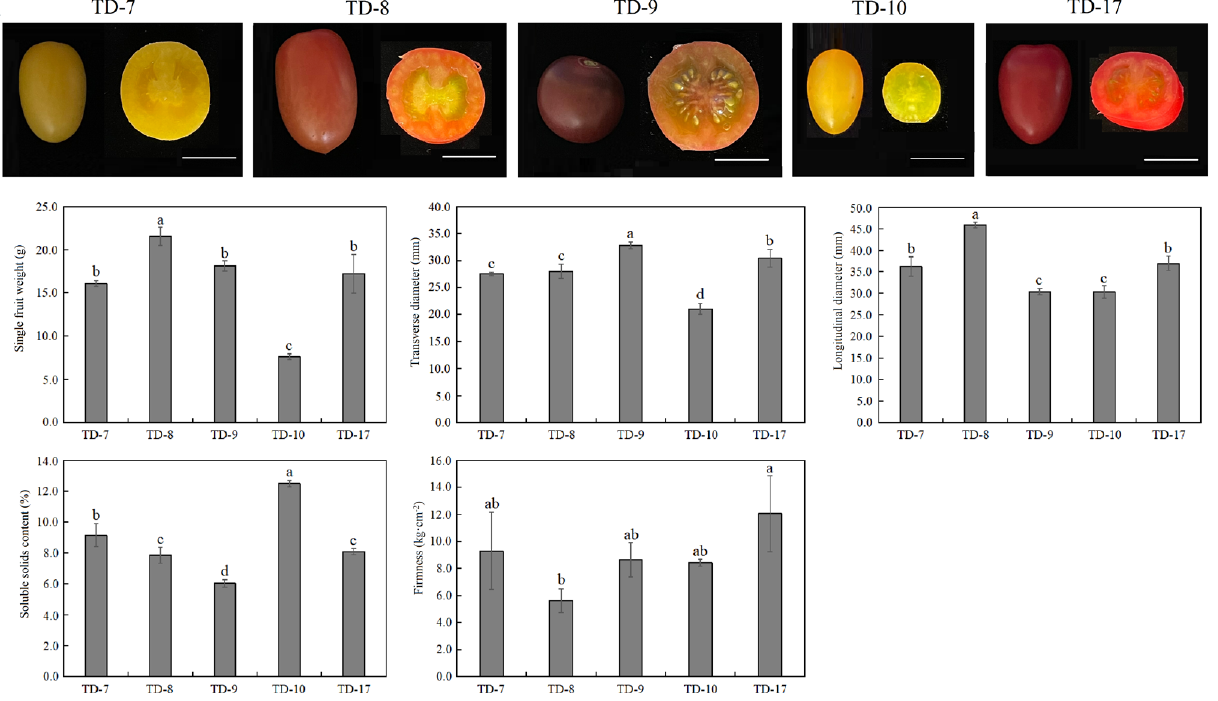
Figure 1. Physiological and quality indicators of mature tomato fruits of different cultivars. ( A ) Growth status of different cultivars of mature tomato fruits. The white lines on the right in each image represent 2 cm; ( B ) Fruit single weight, transverse diameter, longitudinal diameter, soluble solids content, and firmness of mature tomato fruit of different cultivars. Different lower cases indicate a significant difference at 0.05 level.